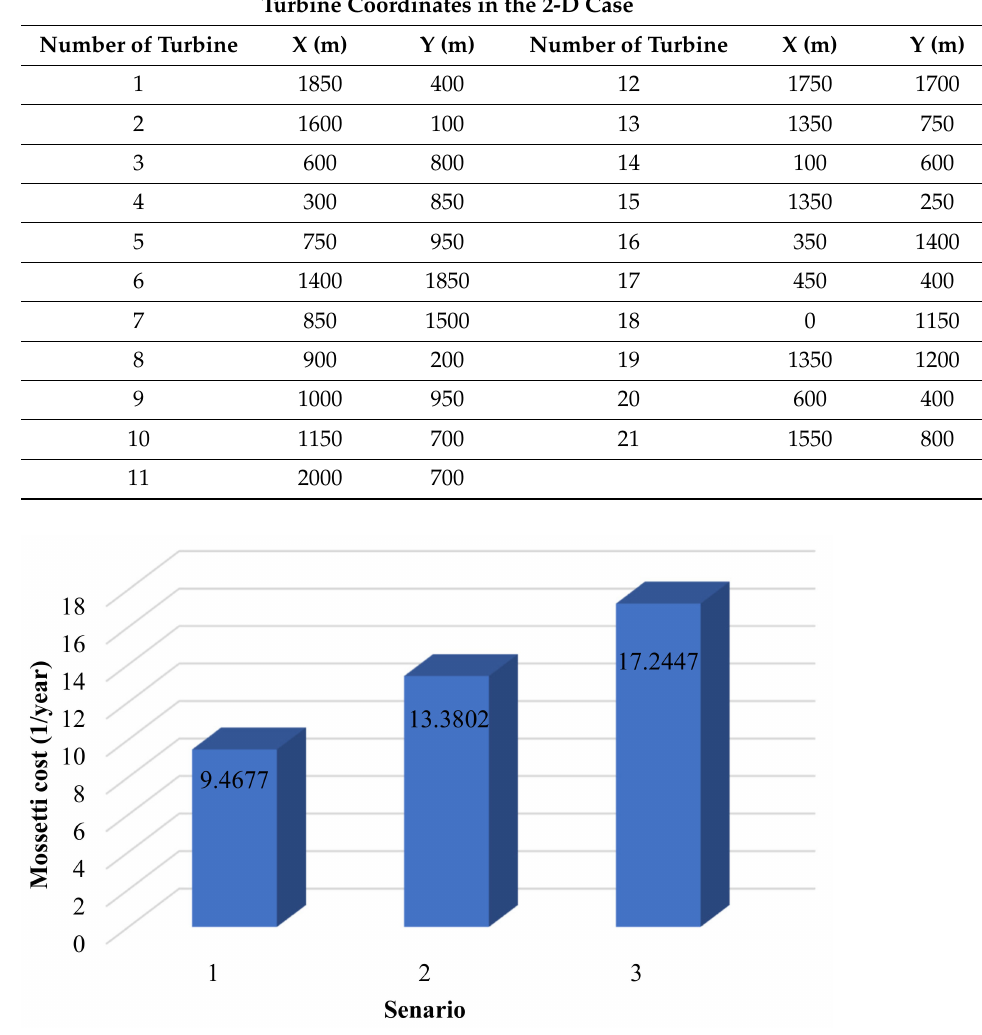
Figure 16. Cost of the wind farm in all cases.